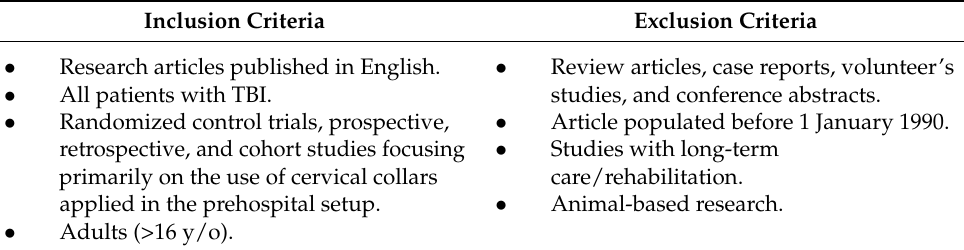
Table 1. Inclusion and exclusion criteria for systematic review. Inclusion Criteria Exclusion